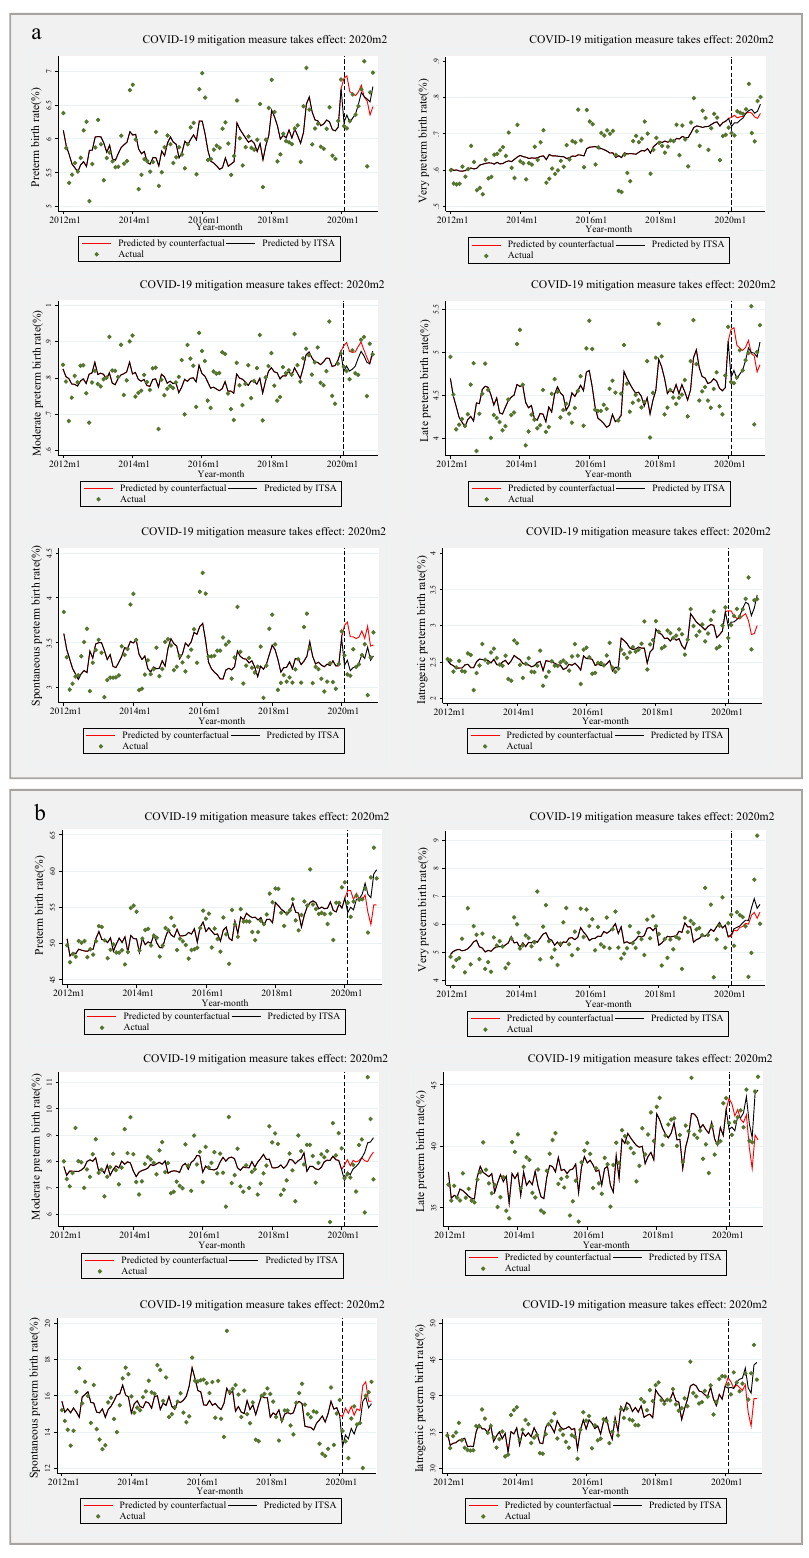
Fig. 1 | Interrupted time series analysis (ITSA) of the preterm birth rate across different type pregnancies in China, 2012 – 2020. a singleton births; b multiple births.Dotsindicatetruemonthlypretermbirthrates,solidlinesindicatethemean of estimated preterm birth rates per month by ITSA model, and red solid lines indicate the mean of estimated preterm birth rates per month assuming that